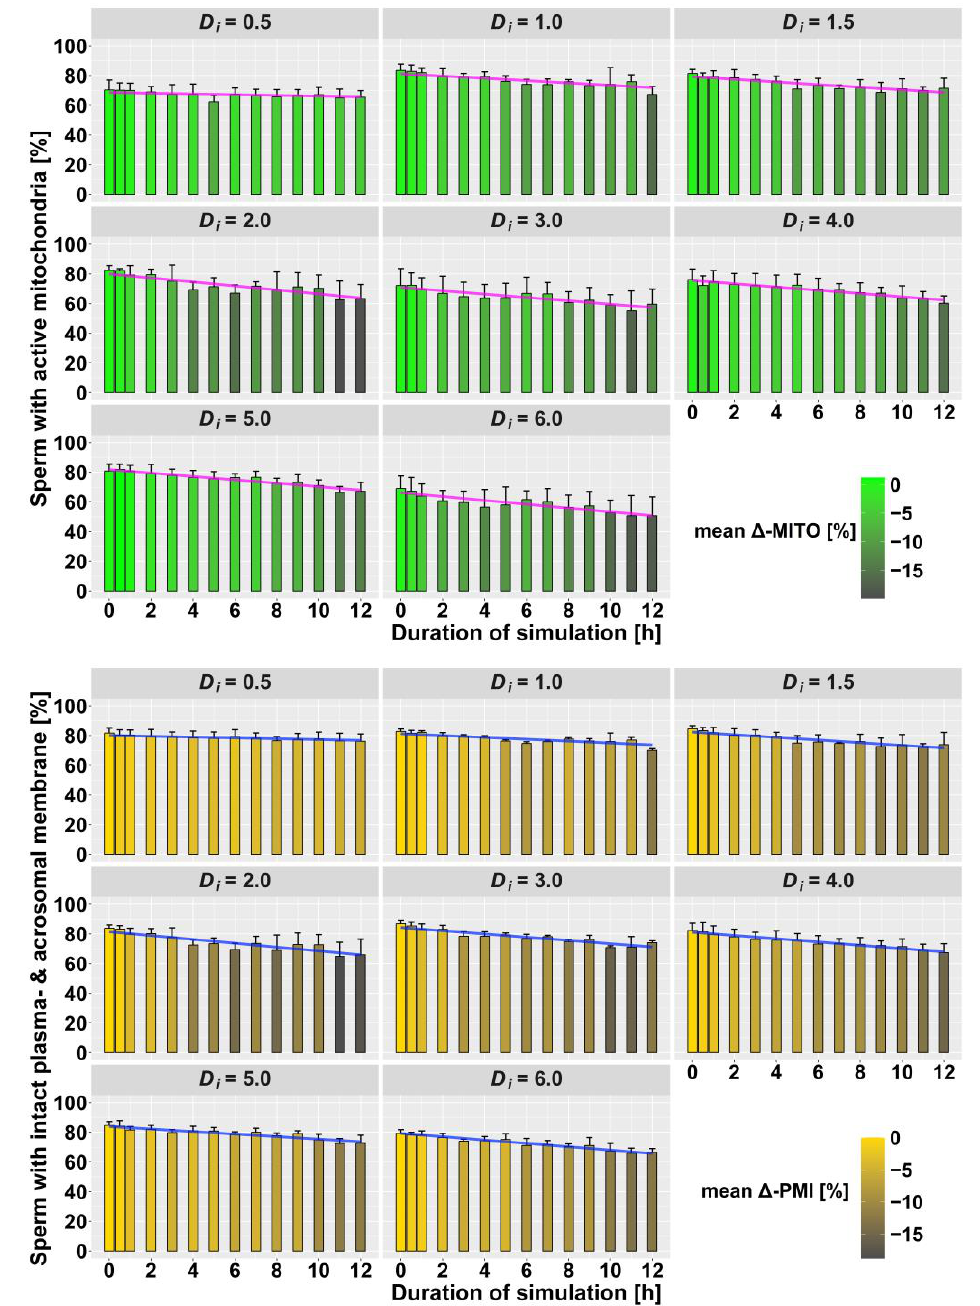
Figure 2. Summary of flow cytometric measurements ( n = 336 samples) on day 4 after treatment: ( a ) mitochondrial activity (MITO); ( b ) plasma membrane and acrosome integrity (PMI). Mean absolute values, grouped by intensity (D i ) and duration (h) of vibration treatment, are shown as bars with standard deviation (SD) as the error bar. The color of the bars represents the mean difference (Δ) to the control group (duration = 0 h). The colored line shows the values of the applied regression model.